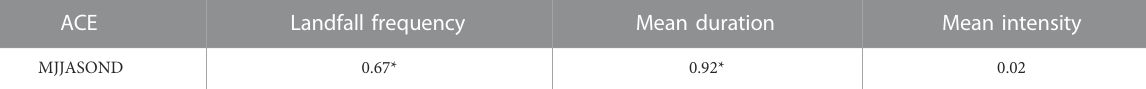
TABLE2CorrelationsofACEduringMay-Decemberwithitsthreecomponents(landfallfrequency,meandurationandmeanintensity)in1979 – 2019.Asterisks represent correlation coef fi cient signi fi cant at the 95% level based on Student ’ s t